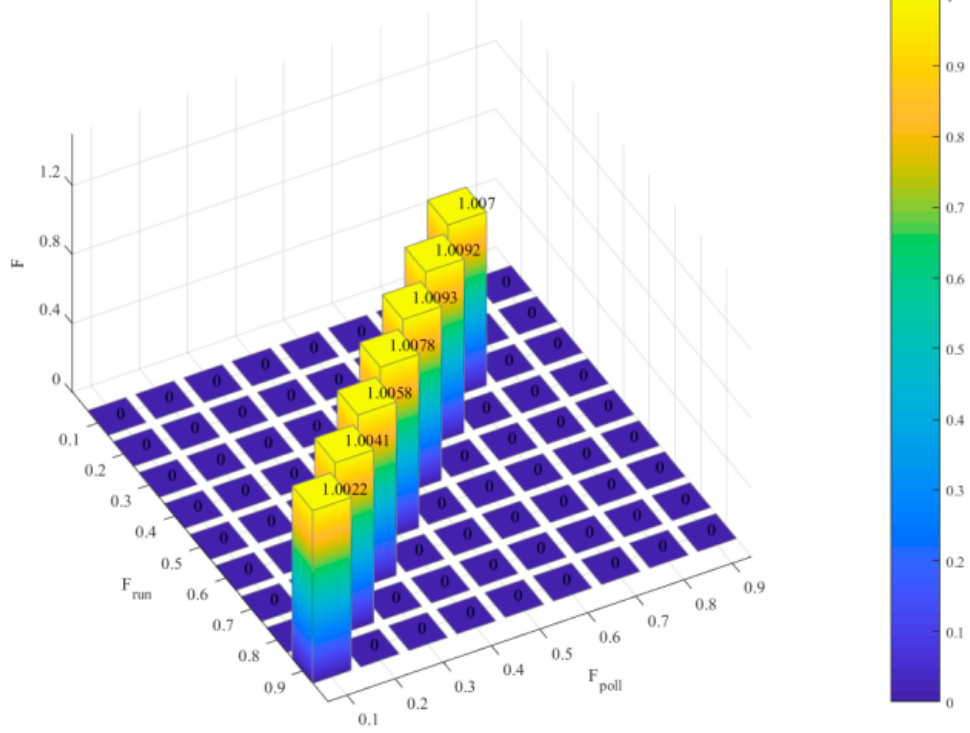
ff erent weights in